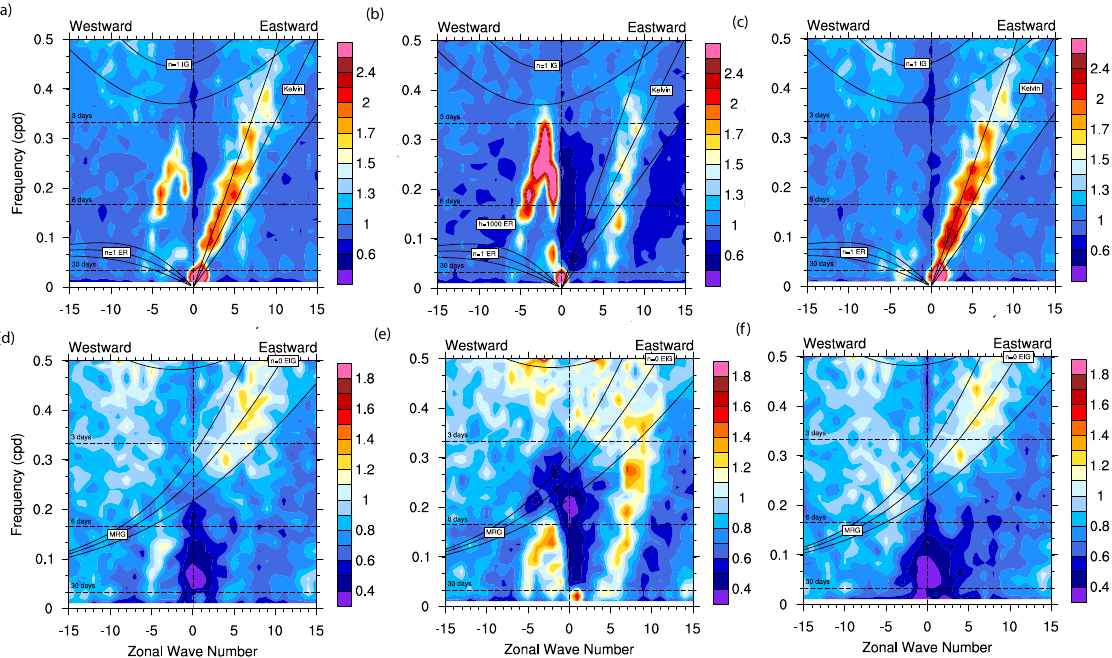
Figure 4. Frequency-wavenumber spectrum of the zonal wind field at 200 hPa, for the symmetric (panels ( a – c )) and antisymmetric (panels ( d – f )) parts of the spectrum; panels ( a , d ) refer to the full spectrum of vertical modes, whereas panels ( b , e ) show the barotropic component and panels ( c , f ) the baroclinic component of the corresponding